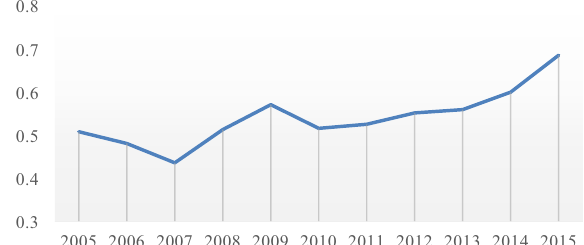
Figure 2. The overall development quality score of China’s manufacturing